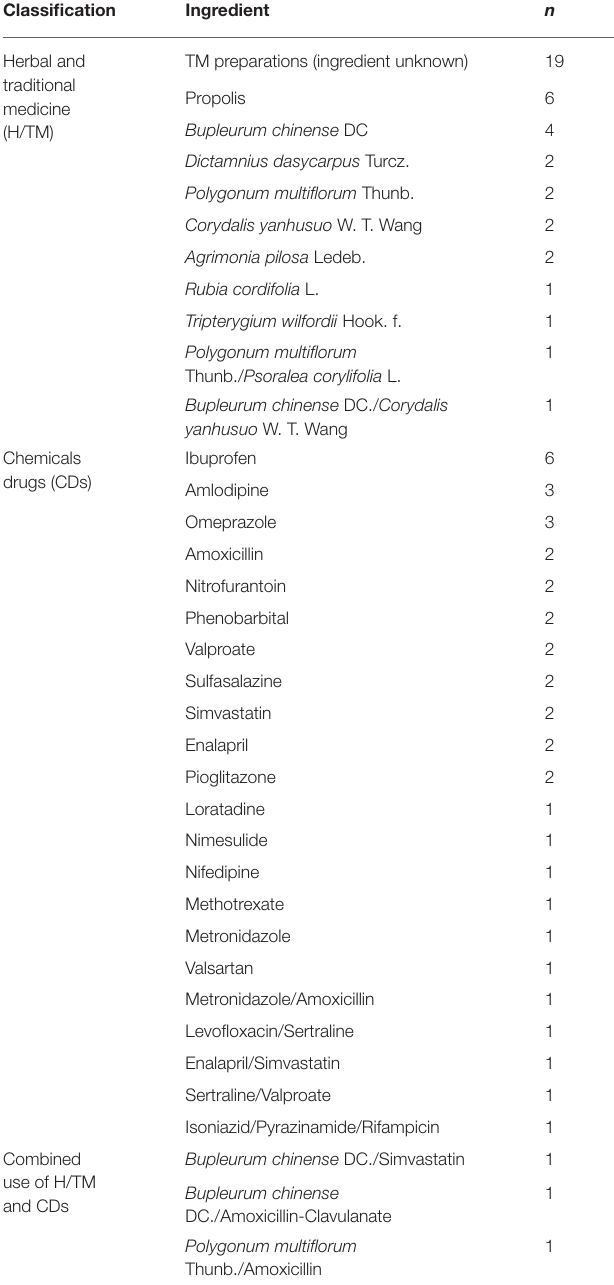
TABLE 2 | The causative agents of enrolled DILI patients. Classification Ingredient n Herbal and